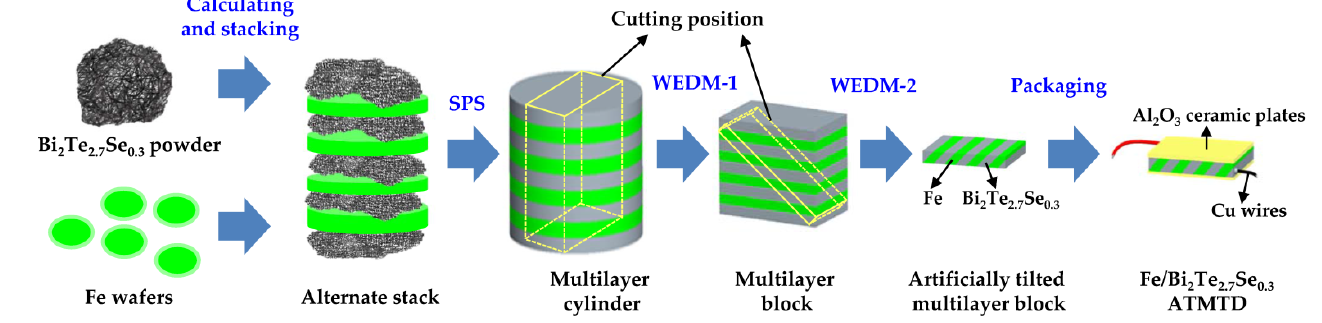
Figure 2. Sketch map of the processes of fabricated Fe/BTS ATMTD.